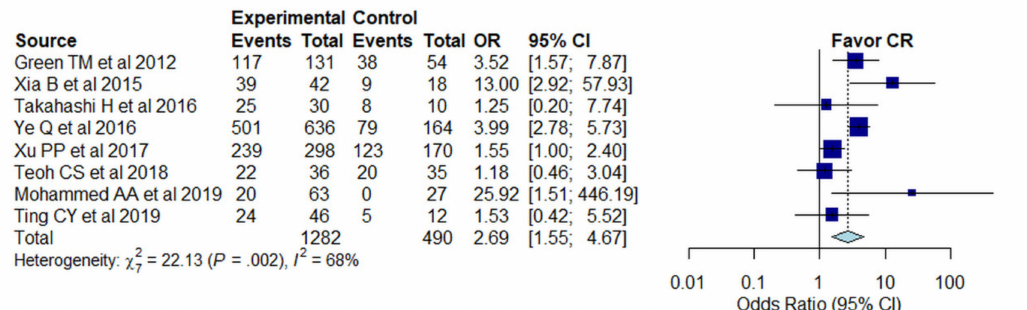
Figure 3. Forest plot shows the pooled odds ratio of complete remission in patients, stratified by double expressor status. The events represent complete remission. The blue box represents the point estimate and its area represents the weight given to the study. Horizontal line indicates the 95% confidence interval. At the bottom of the plot, the overall pooled odds ratio is represented by the dashed vertical line and the diamond. The solid vertical line indicates no